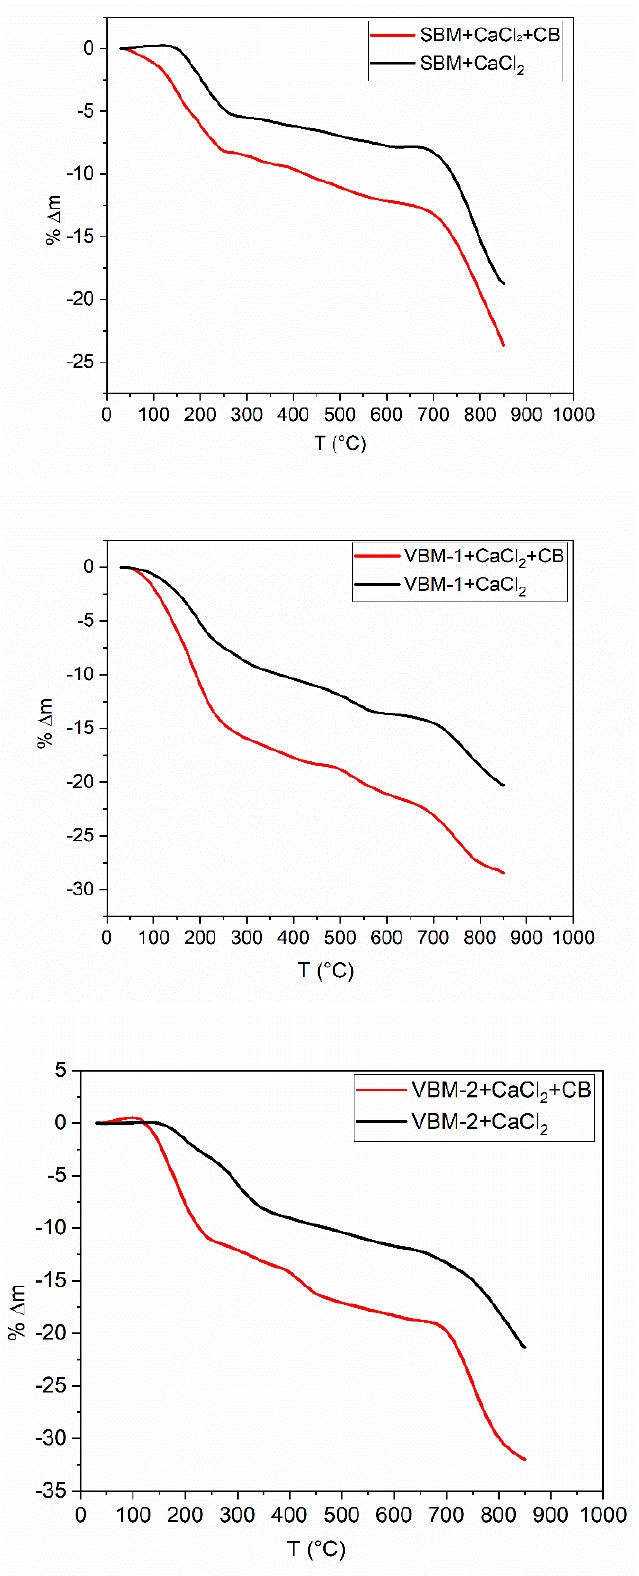
Figure 3. TGA of the BM/CaCl 2 and BM/CaCl 2 /carbon black mixture in N 2 stream.